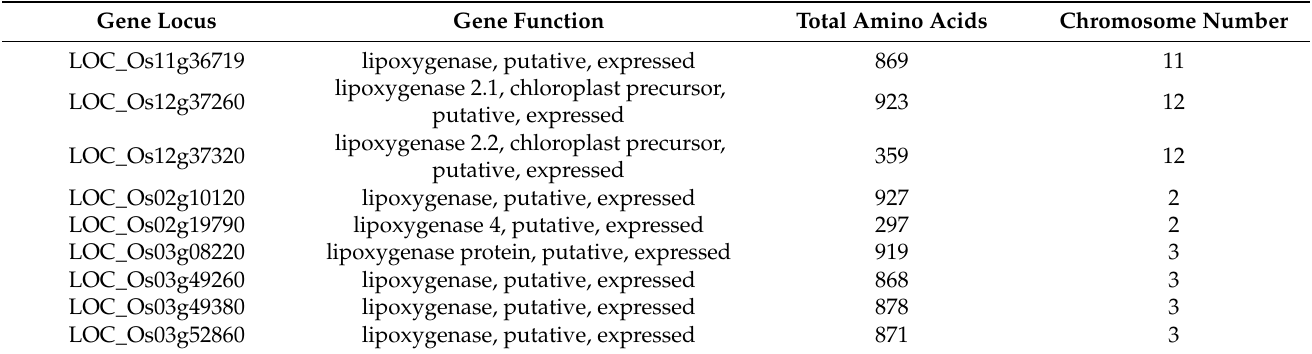
Table 2. Genes encoding LOX in Oryza sativa